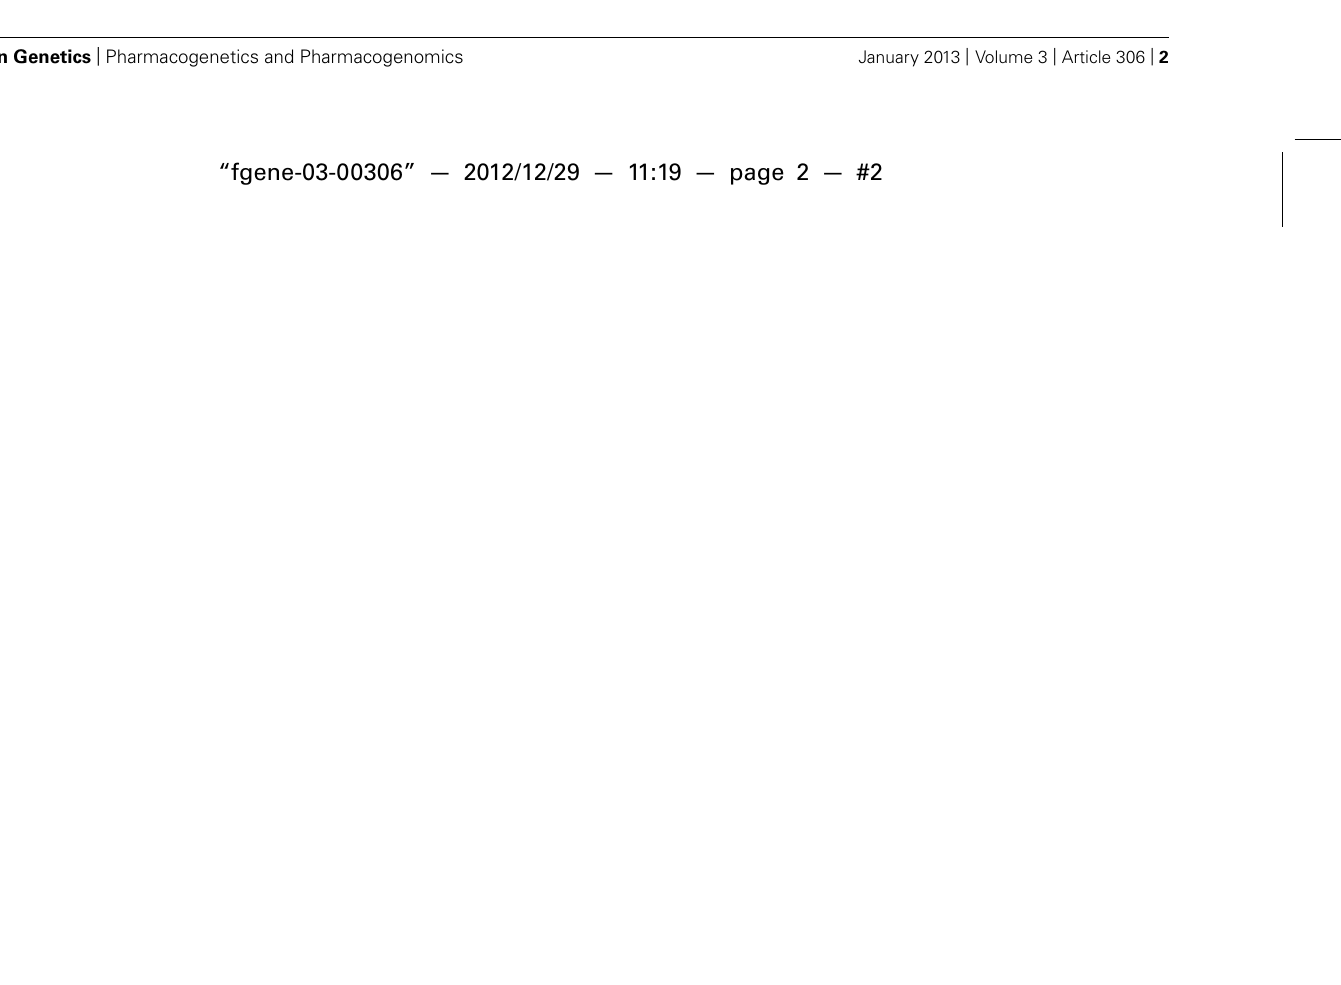
located in exon 4. (B) Phylogenetic tree of the ABCC subfamily including CFTR, SUR1, SUR2, and MRPs.The phylogenetic tree was modified from Toyoda etal. (2008).The phylogenetic relationships among members of the “C” sub-family of human ABC transporters were calculated by using the distance-based neighbor-joining methods (Saitou and Nei,